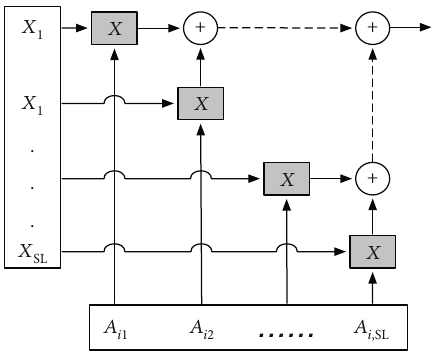
Figure 4: Parallel inner-product architecture.